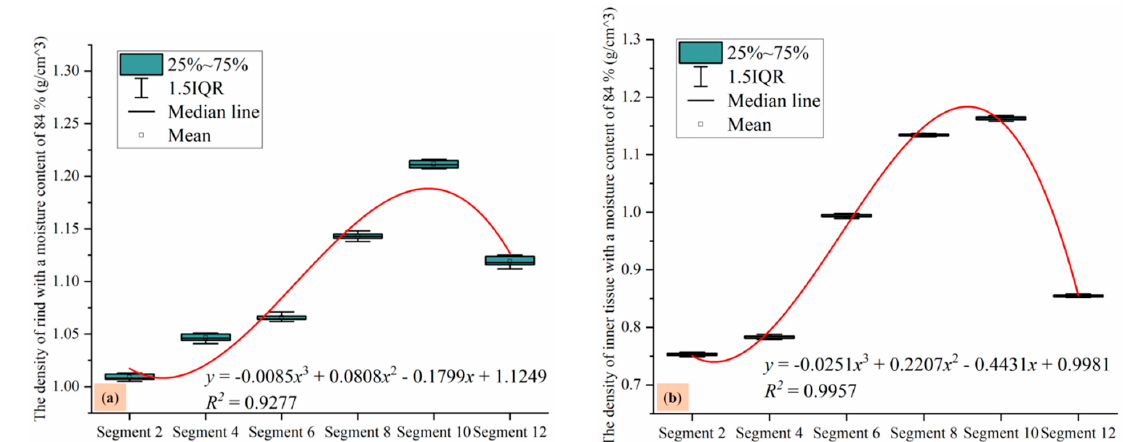
Figure 10. The relationship between the density of bunch stalks with a moisture content of 84% and the segments. ( a ) The relationship between the density of rind and the segments; ( b ) the relationship between the density of inner tissue and the segments.